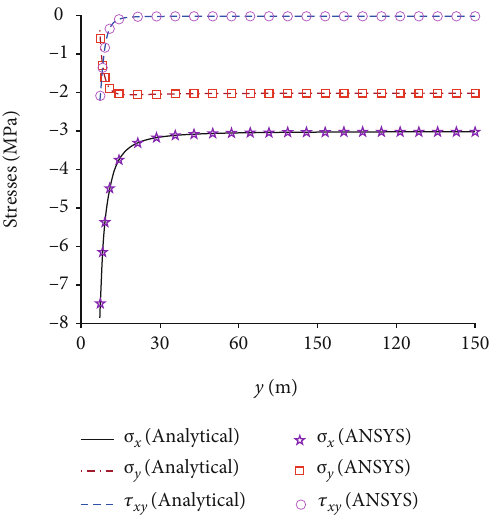
Figure 4: Comparison of stresses along the tunnel